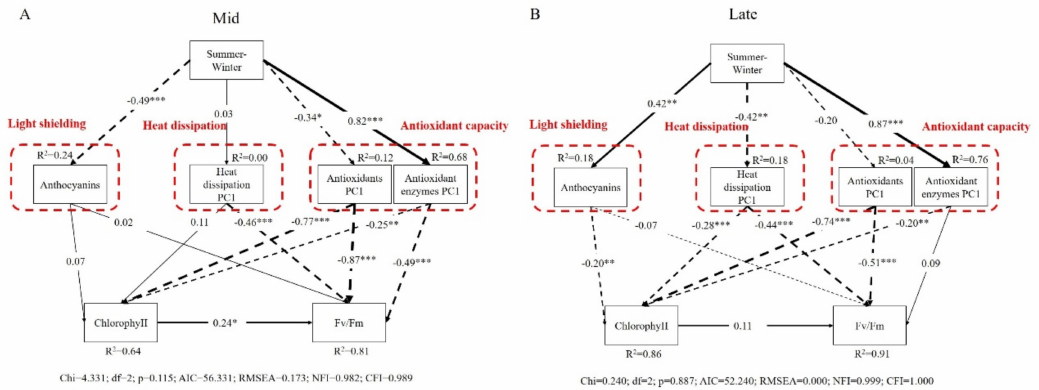
Figure 6. Path model of the relationships among anthocyanins, heat dissipation capacity, antioxidant substances, antioxidant enzymes, chlorophyll, and Fv/Fm of dominant species ( A ) in the mid- successional stage and late-successional stage ( B ) in summer and winter. Solid arrows represent positive effect paths and dashed arrows represent negative effect paths; thicker arrows indicate greater significance. Standardized regression coefficient is shown for each path. R2 indicates total variation in a dependent variable that is explained by the combined independent variables. Model-fit statistics are provided. Chi, Chi-square; df, degrees of freedom, p, probability level; CFI, comparative fit index; AIC, Akaike information criterion; RMSEA, root mean square error of approximation; NFI, normed fit index. * Significant difference at 0.05 level, ** 0.01 level, *** 0.001